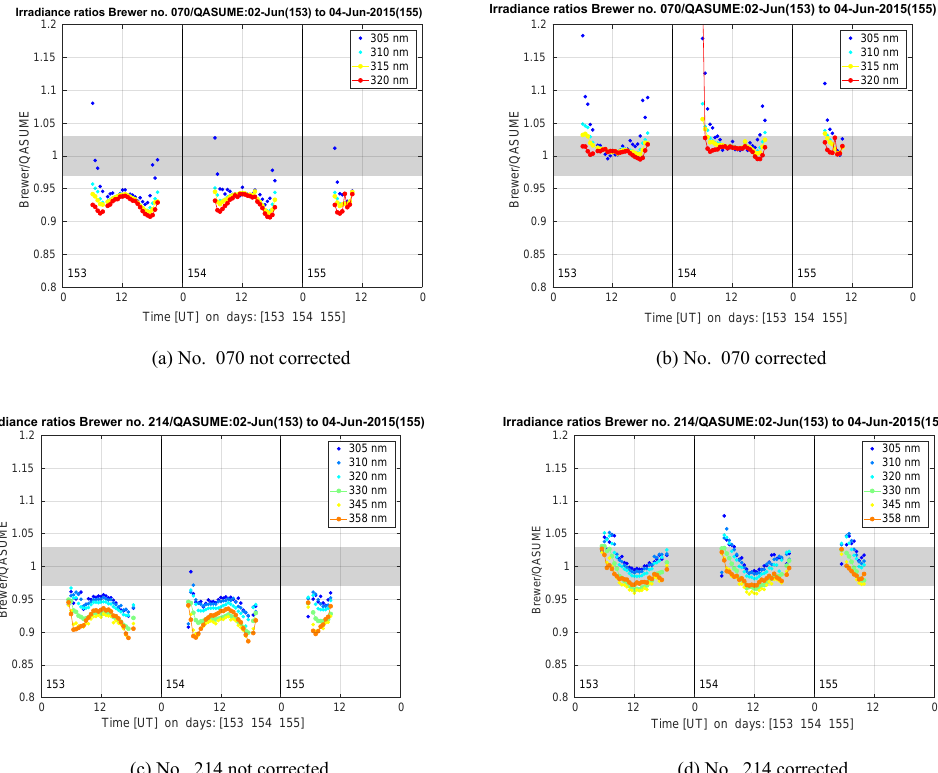
Figure 8. The mean ratios between Brewers (a, b) no. 070, (c, d) no. 214 and QASUME irradiances at specific wavelengths for measurements done at SZA < 90 ◦ in the comparison campaign in Huelva during 2–4 June 2015. The data in plots (b) and (d) was cosine error corrected and in plots (a) and (c) was not corrected. The grey-shaded area in the figure represents the uncertainty of the QASUME spectroradiometer at 95% confidence